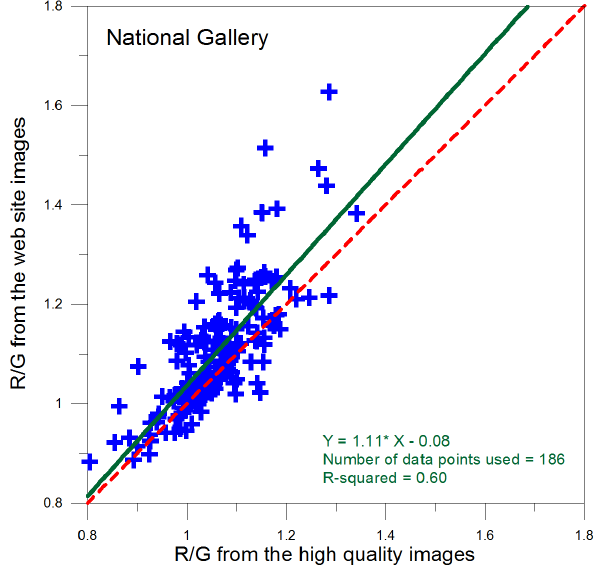
Fig. 2. Distribution of the relative differences (in %) between the R/G ratios derived from the high- and the low-resolution im- ages from 124 landscape sunsets at the Tate Gallery (listed in Ap- pendix A).